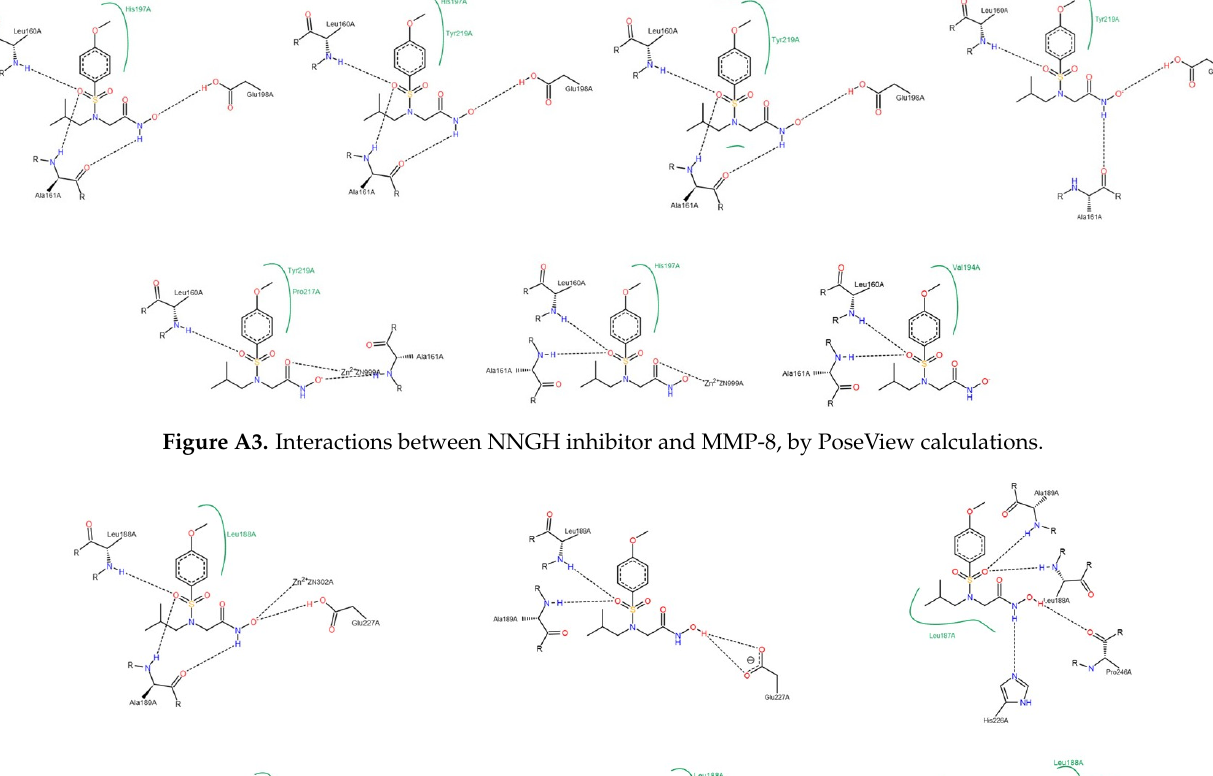
Figure A2. Interactions between NNGH inhibitor and MMP-2, by PoseView calculations.